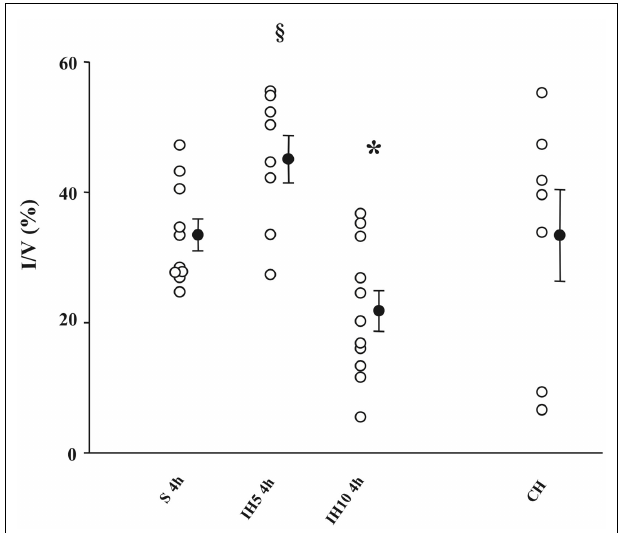
FIGURE 1 | Infarct size (I) expressed as a percentage of ventricles (V) assessed after a no-flow global ischemia (30min)-reperfusion (120min) sequence in groups of mice exposed to 4h of normoxia (S), intermittent hypoxia (IH, FiO 2 = 5 or 10%), or chronic hypoxia (CH) . * P < 0.05 versus the other groups; § P < 0.05 versus S; 4h, and IH10, 4h. From Ref.